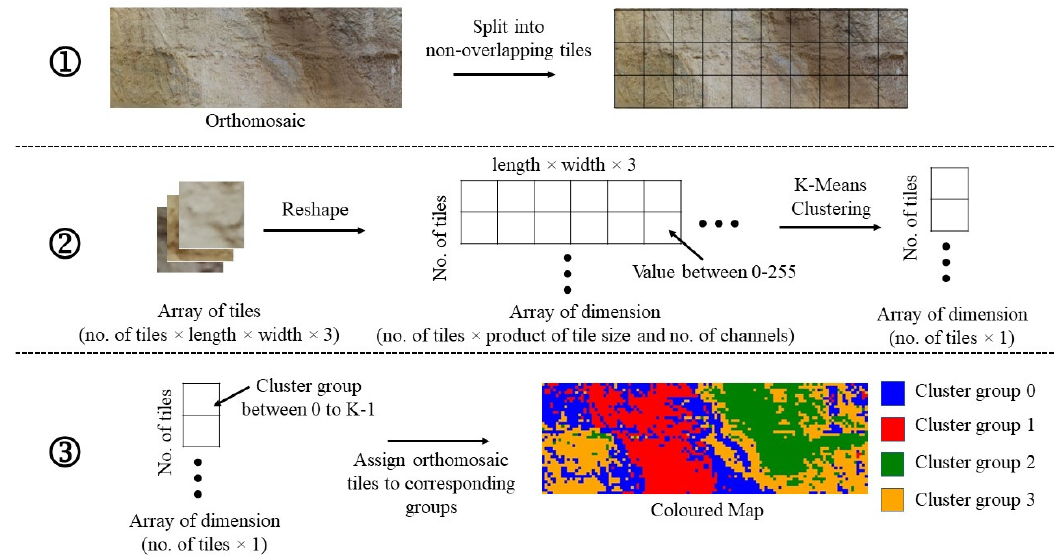
Figure 6. An illustration of the cluster map generation process using K-Means clustering only.